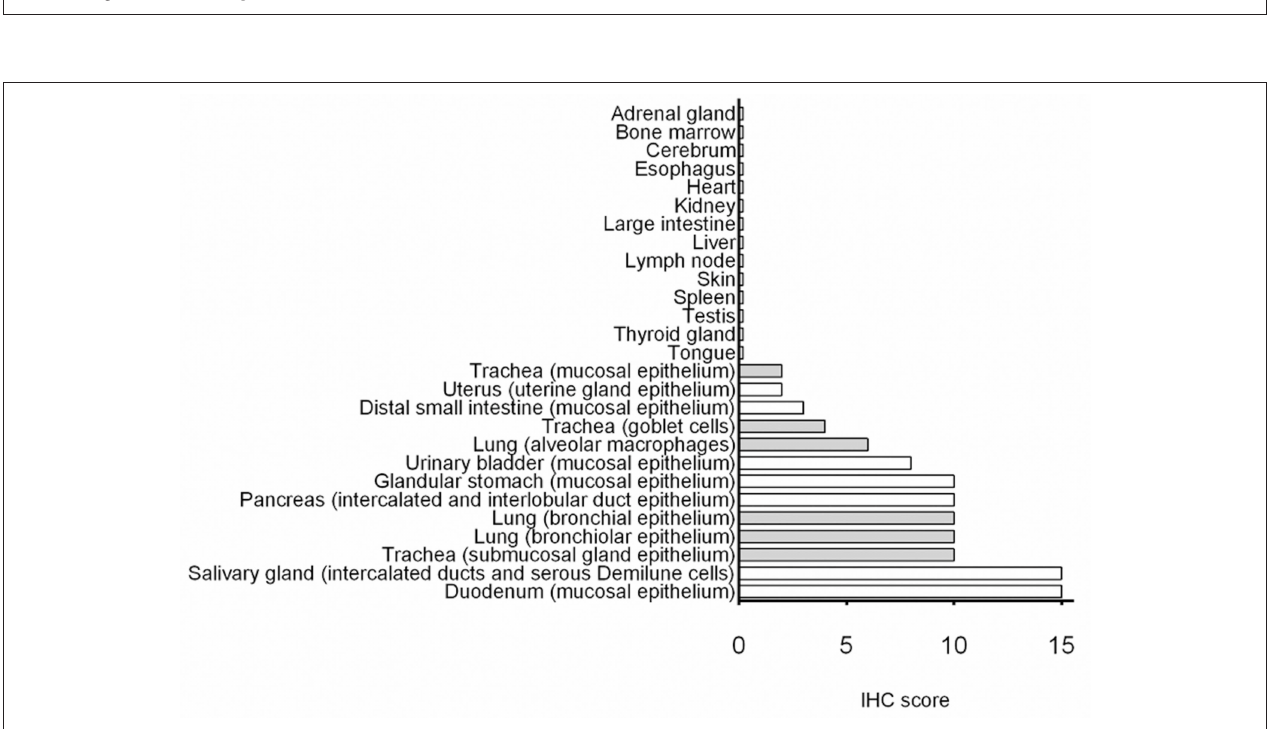
FIGURE 6 | Summary of immunohistochemical detection of SALSA in 27 anatomical sites. IHC scores were calculated using a combination of staining intensity and proportion of cells with positive staining. Bars filled in gray represent tissues from the respiratory tract.